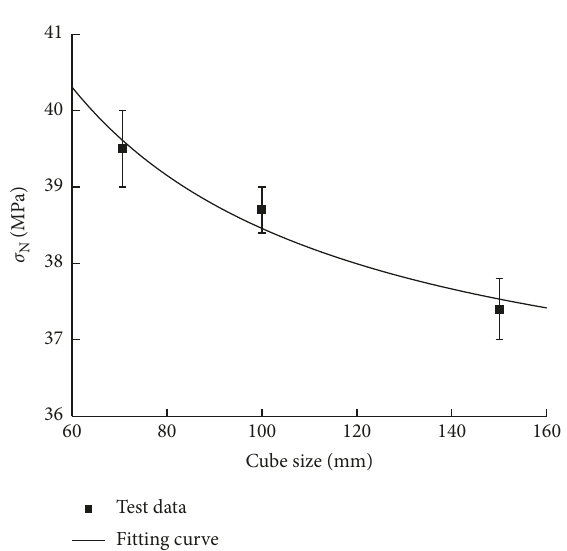
Figure 4: The fitting curve of concrete SEL before drying.